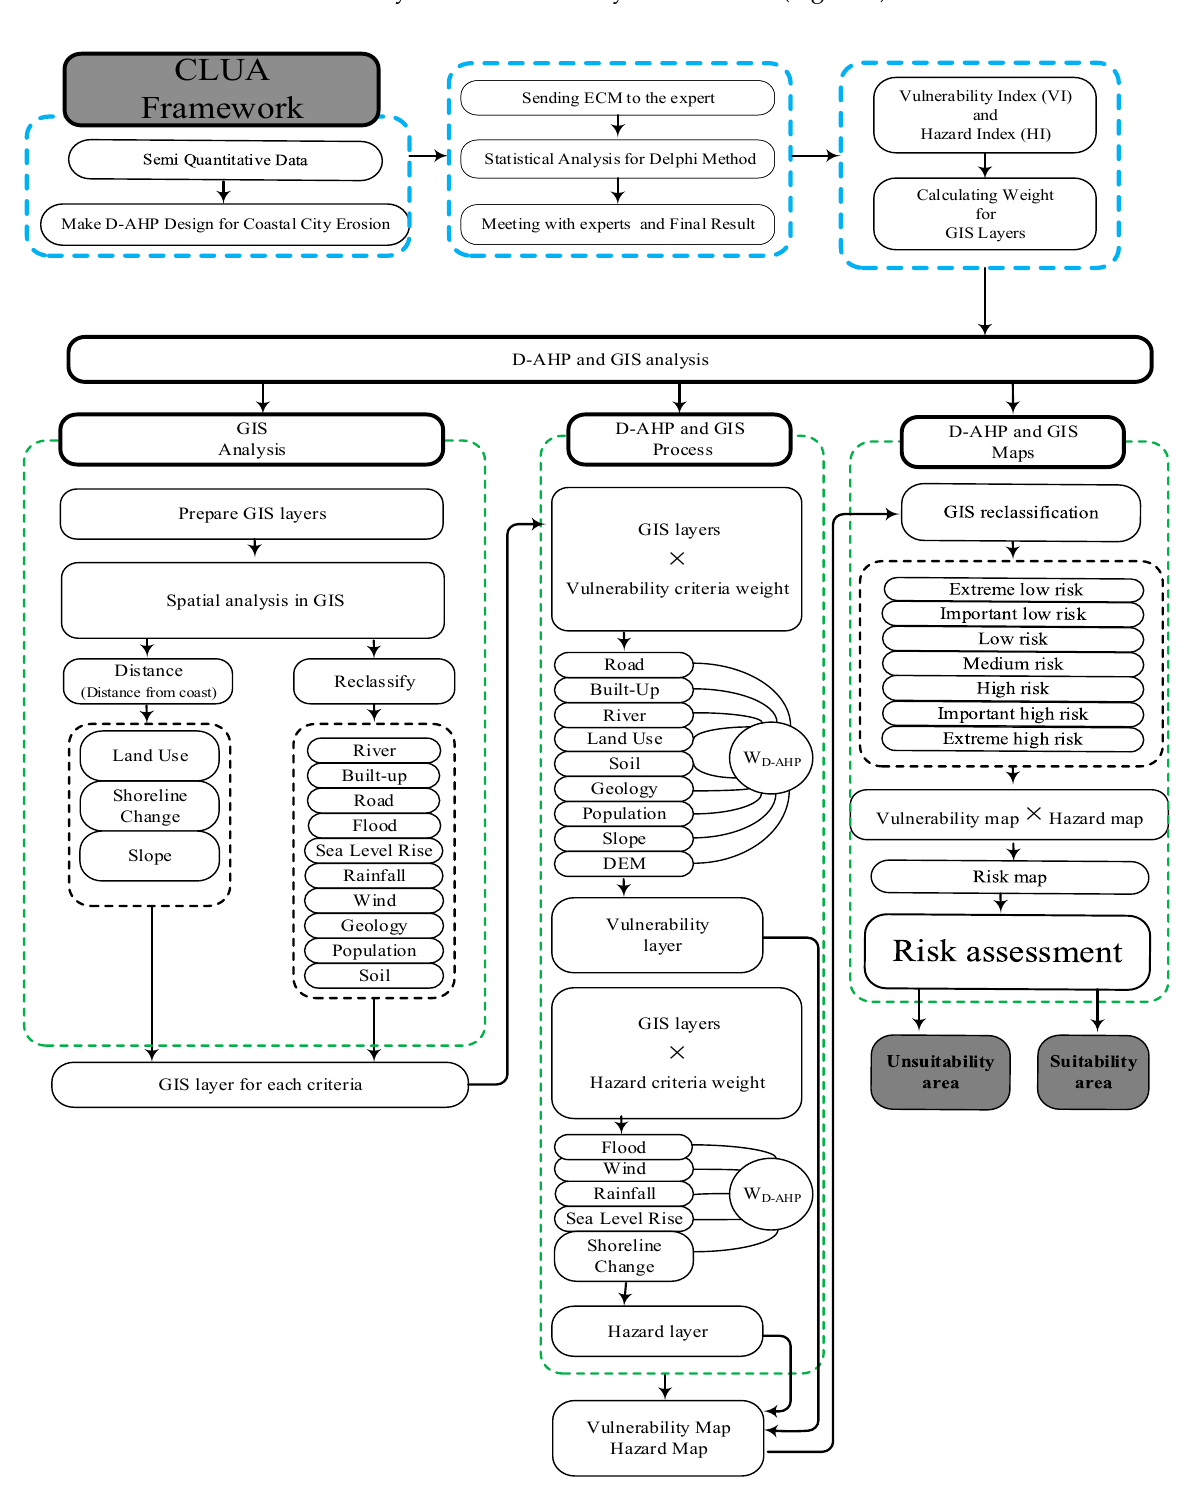
Figure 2. Risk assessment model framework for Kuala Terengganu Structuring the decision hierarchy comprises the disintegration of the decision problem.